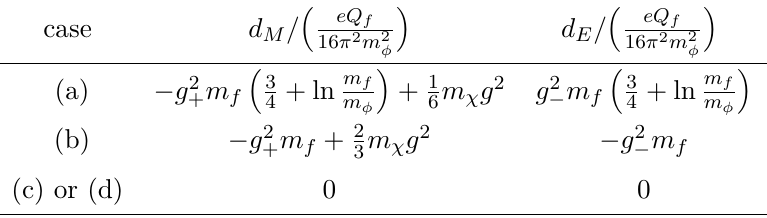
Table 3 . Electromagnetic dipoles generated by the loop diagram in figure 1 for cases